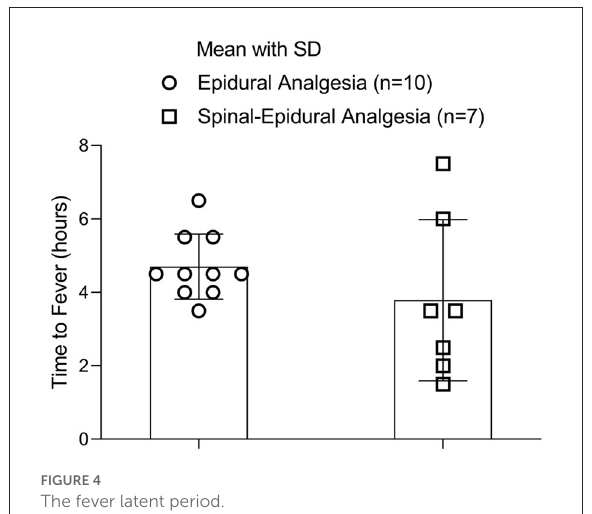
FIGURE4 The fever latent